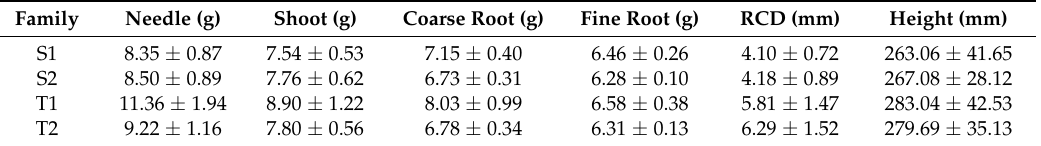
Table 1. Initial family dry matter, root collar diameter (RCD) and height averages and standard deviations ( n = 160;